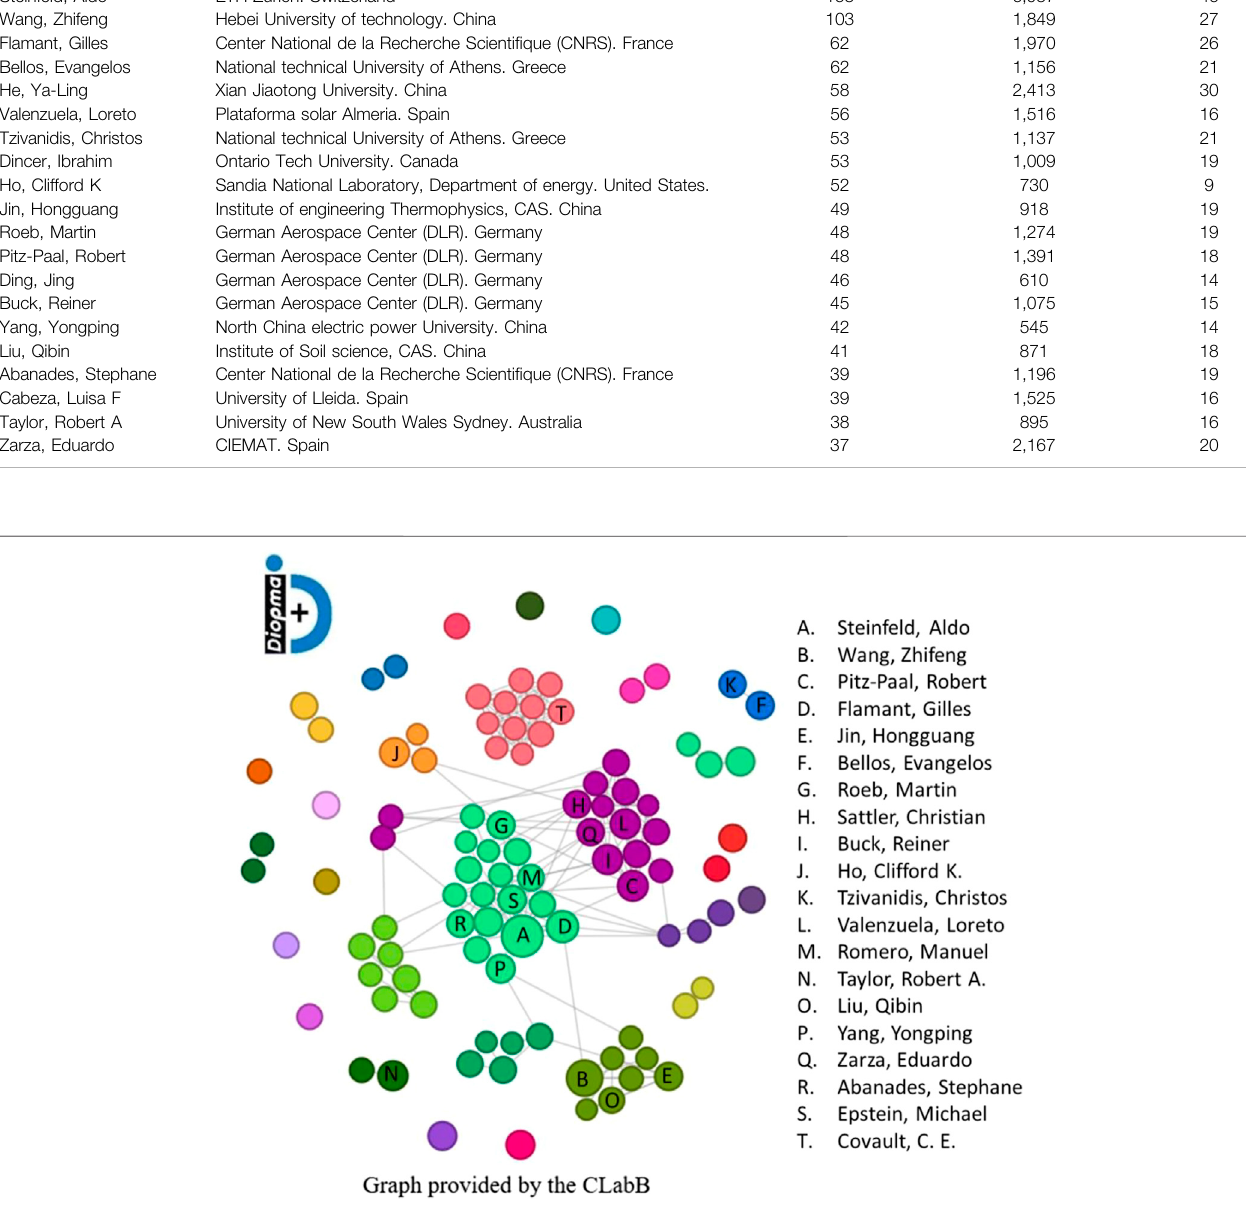
Frontiers in Mechanical Engineering |